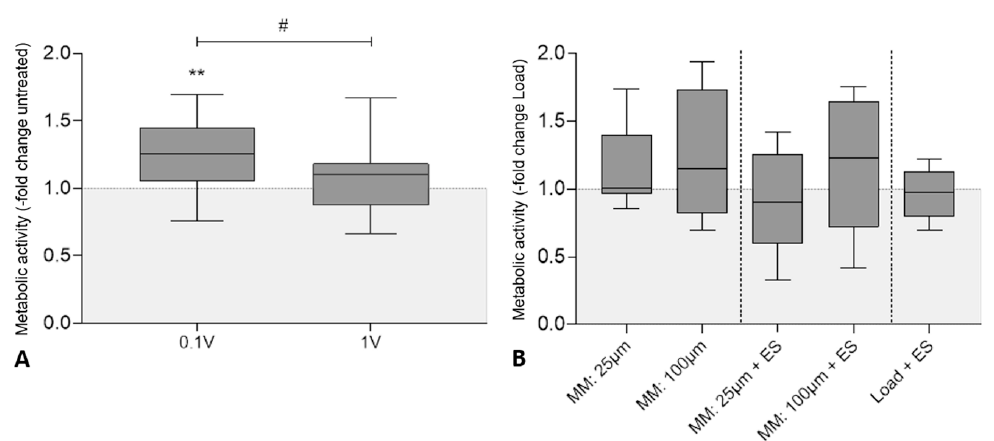
Figure 3. Metabolic activity of human osteoblasts after biophysical stimulation. ( A ) Results of electrical stimulation (ES) with 60 kHz and either 100 mV RMS or 1 V RMS . ( B ) Results of micromotions and electrical stimulation with 60 kHz and 1 V RMS (MM + ES) compared to osteoblasts treated solely with micromotions (MM) and osteoblasts treated with titanium bodies and electrical stimulation (Load + ES). Untreated cells with or without titanium bodies served as controls. The metabolic activity was determined colorimetrically by the conversion of tetrazolium salt to formazan. Results are presented as box plots related to the untreated controls ( n ≥ 6). ** p < 0.01 compared to the untreated controls (Wilcoxon’s signed-rank test); # p < 0.05 comparison between different voltages (Mann– Whitney U test).